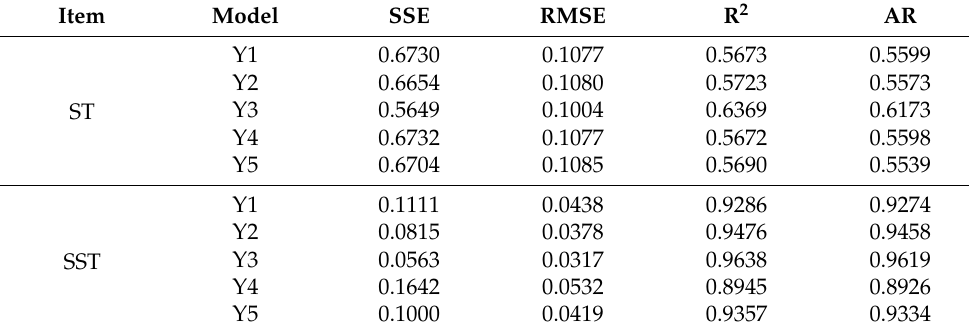
Figure 5. SST and NDVI model results. Table 3. Evaluation of the temperature construction